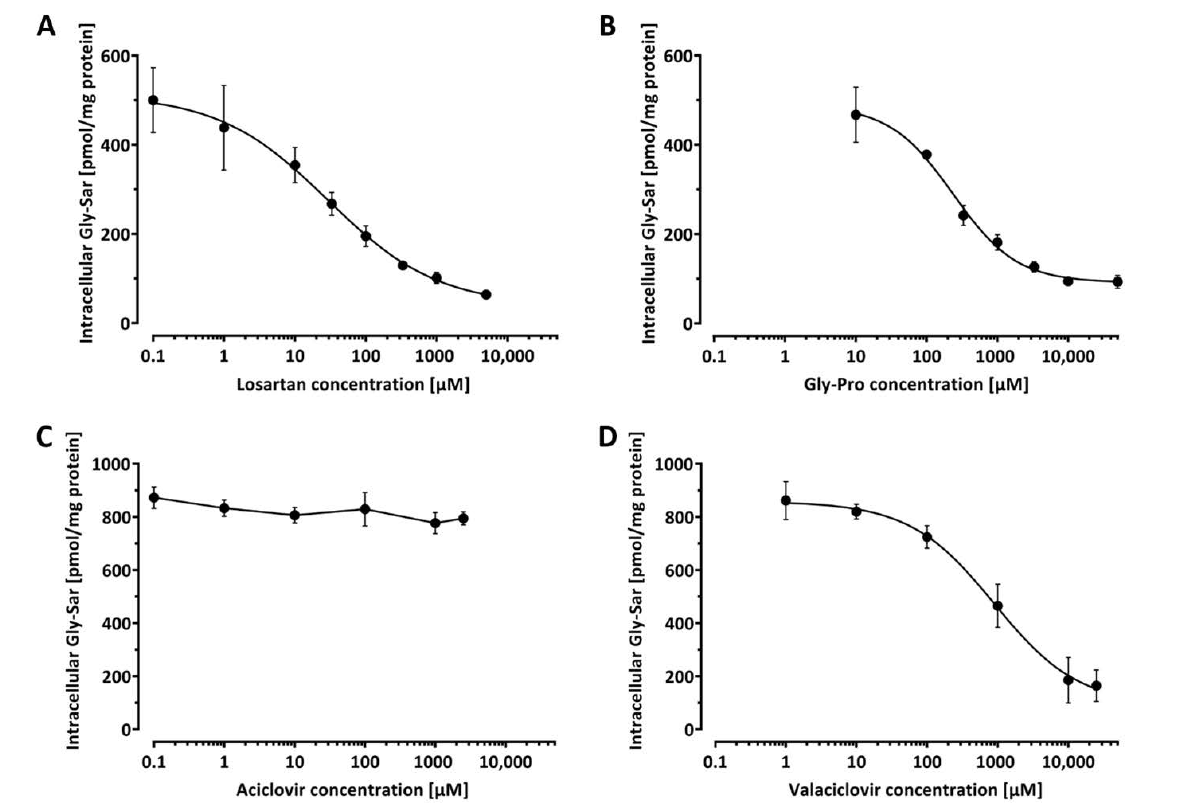
Figure 3. Concentration–response curves on Caco-2 cells for the inhibition of PEPT-1 mediated transport of 20 µ M Gly-Sar by losartan ( A ), Gly-Pro ( B ), aciclovir ( C ), and valaciclovir ( D ). Each data point is a mean of three independent experiments, each experiment performed at least in quadruplet